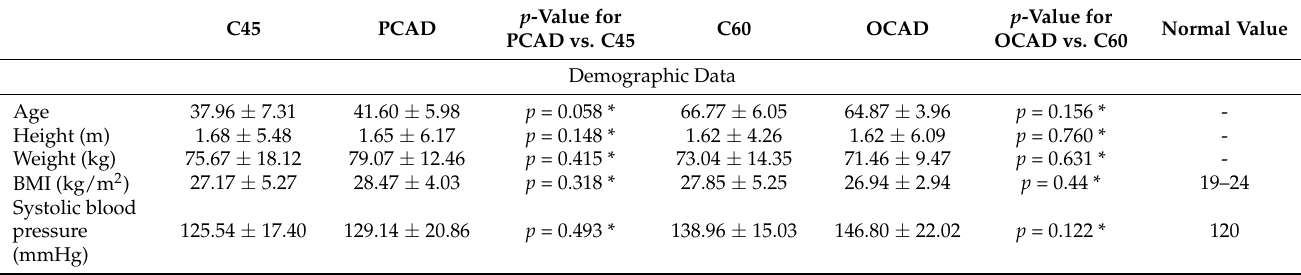
Table 1. Demographic and biochemical profiles of subjects. Data are presented as mean ±